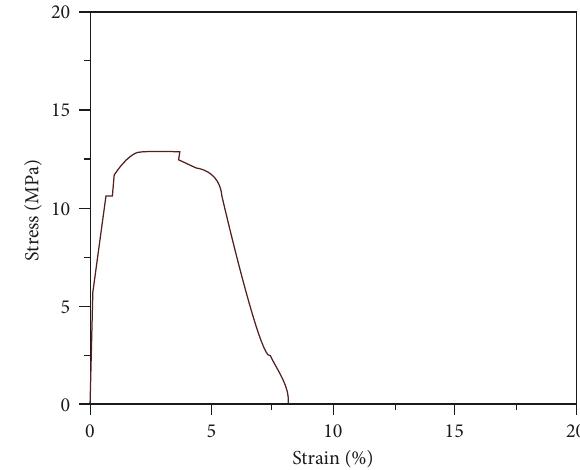
Figure 7: FTIR spectrum of different composites.